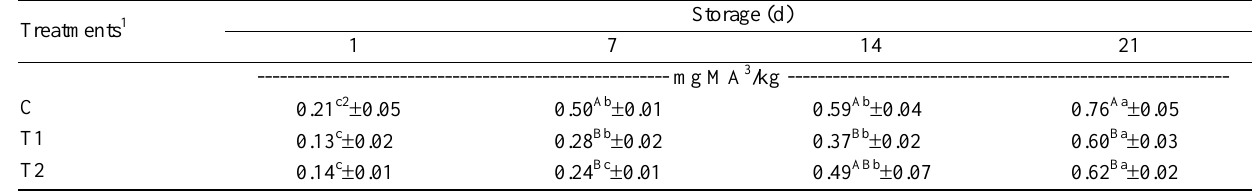
1 C: ziplock bag packaging, T1: vacuum packaging, T2: MAP (CO 2 /N 2 = 3:7), and MA: malondialdehyde. 2 A-B Means SD with different superscripts in the same column differ significantly at p<0.05. a-c Mean SD with different superscripts in the same column differ significantly at p<0.05.